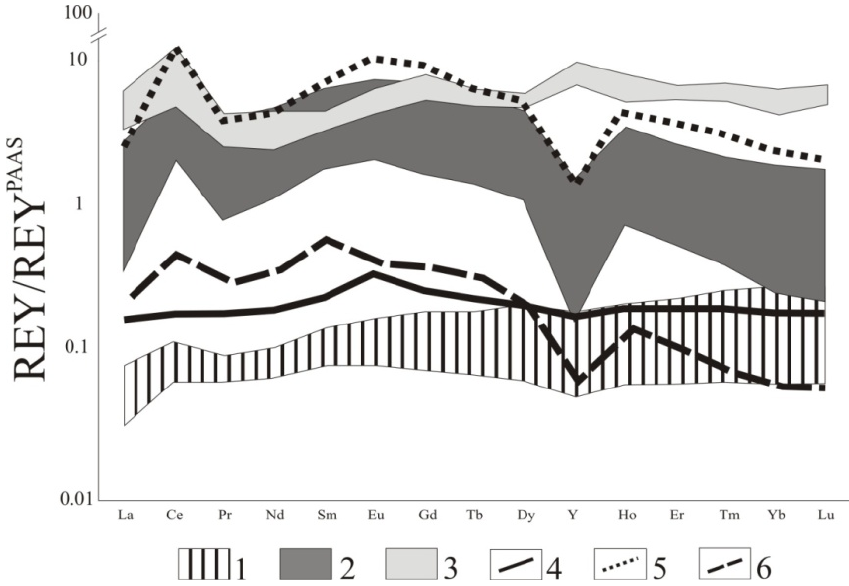
Figure 11. Shale-normalized (PAAS after [47]) REY patterns of Fe-Mn deposits of di ff ering genesis in fraction IV (legend see in Figure 7).